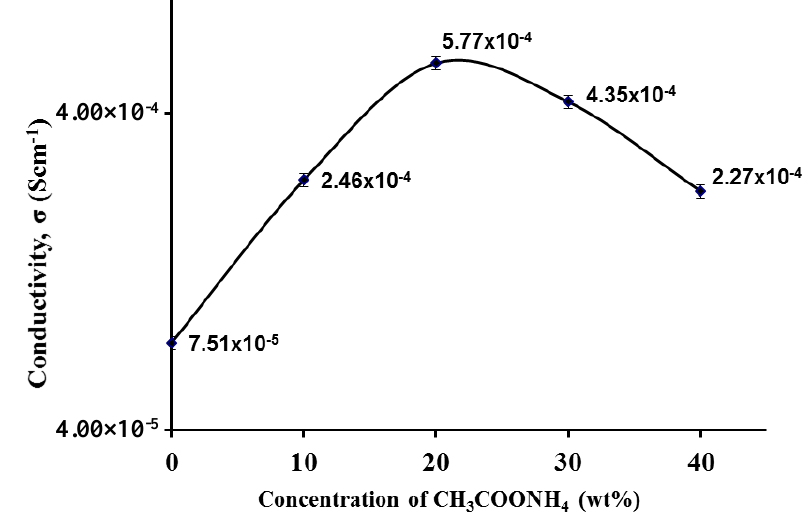
Figure 9. Schematic diagram of CMC interaction with CH